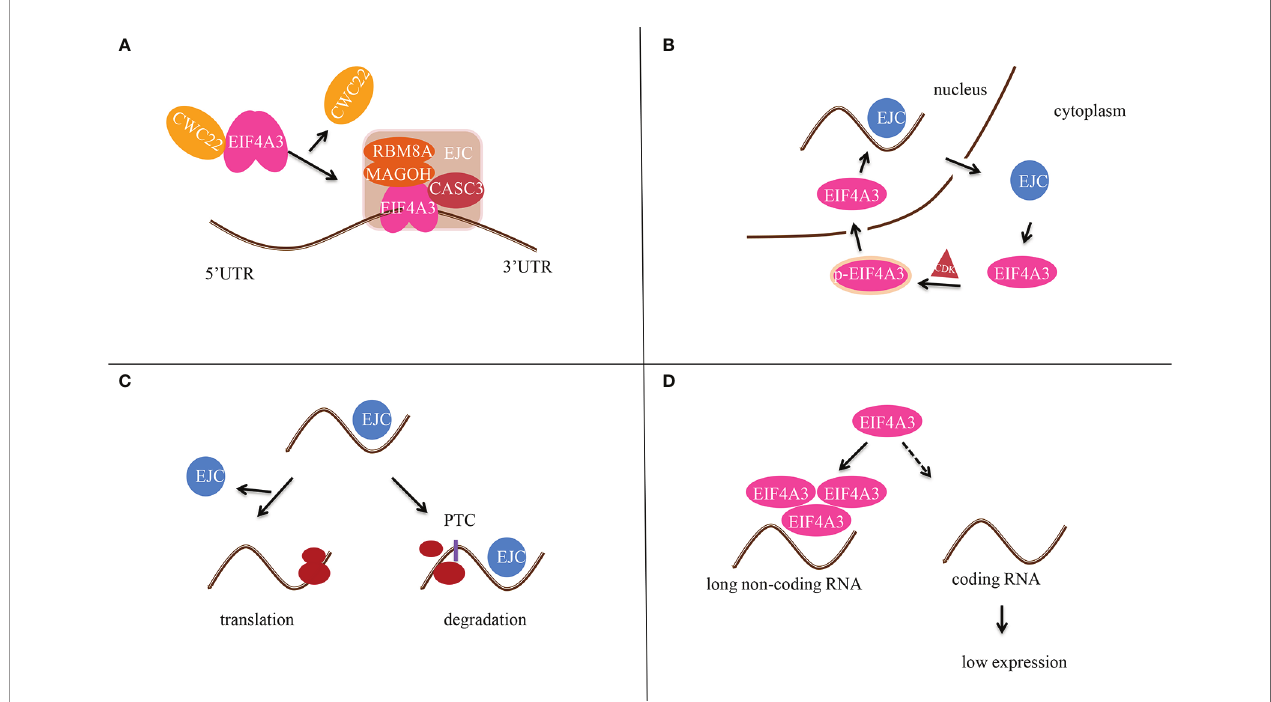
FIGURE 2 | Scheme of the molecular mechanism of EIF4A3 in post-transcriptional gene regulation. (A) EIF4A3 fi rst binds to RNA in a CWC22-dependent manner, and then to the MAGOH-RBM8A complex to form the precursor EJC. CASC3 then binds to EIF4A3 after RNA splicing to form the EJC tetramer. (B) EIF4A3 is phosphorylated (p-EIF4A3) by CDK1/CDK2 in the cytoplasm and enters the nucleus. After dephosphorylation in the nucleus, the EJC complex is formed. Next, EIF4A3 is transferred out of the nucleus and is released from the EJC complex. (C) In the case of normal mRNA, EJC dissociates before translation. In contrast, if the mRNA contains a premature termination codon (PTC), the EJC does not dissociate and it hinders translation. (D) EIF4A3 is recruited by long non-coding RNAs (lncRNAs) to reduce its aggregation around RNAs, thereby affecting the translation of target